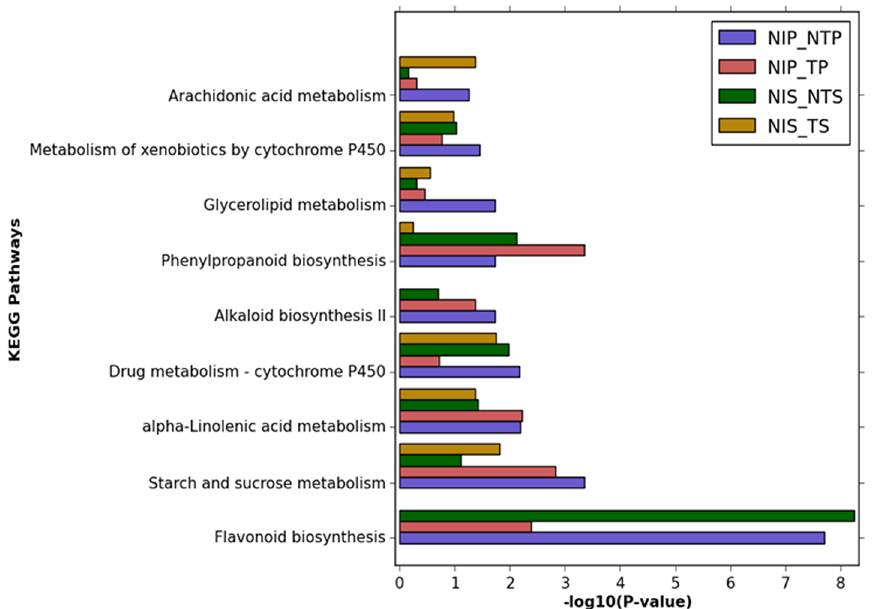
Fig 7. Highly represented KEGG metabolic pathways in pericarp and seed tissues of cotton under A . flavus infection. The X-axis represents the enrichment in terms of P-value and Y-axis represents the biochemical